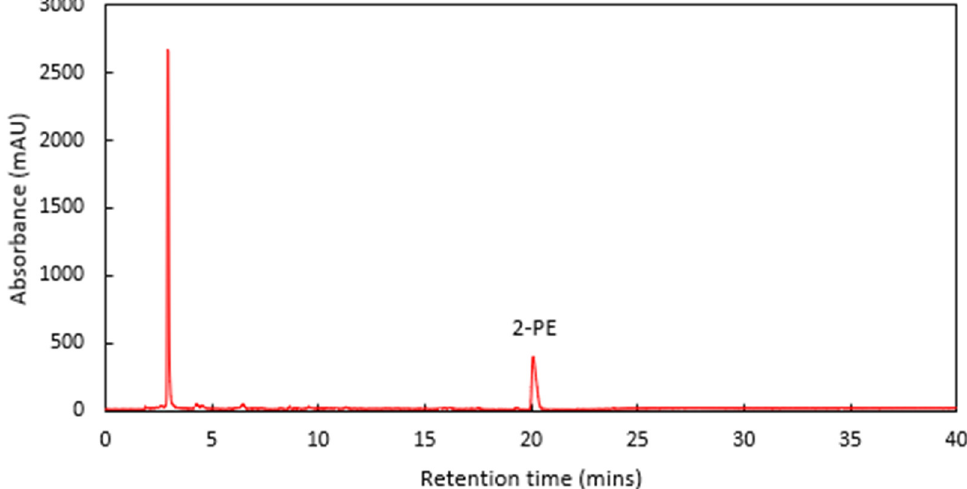
Figure 2. HPLC chromatogram output (at 250 nm) of a cider sample spiked with 2-phenylethanol (4.0 g L − 1 ), showing the elution of numerous polar compounds within the first 17 min of the run, followed by the elution of the target compound (2-phenylethanol) at 20.102 min, then elution of remaining unwanted non-polar compounds from 22–30 min.